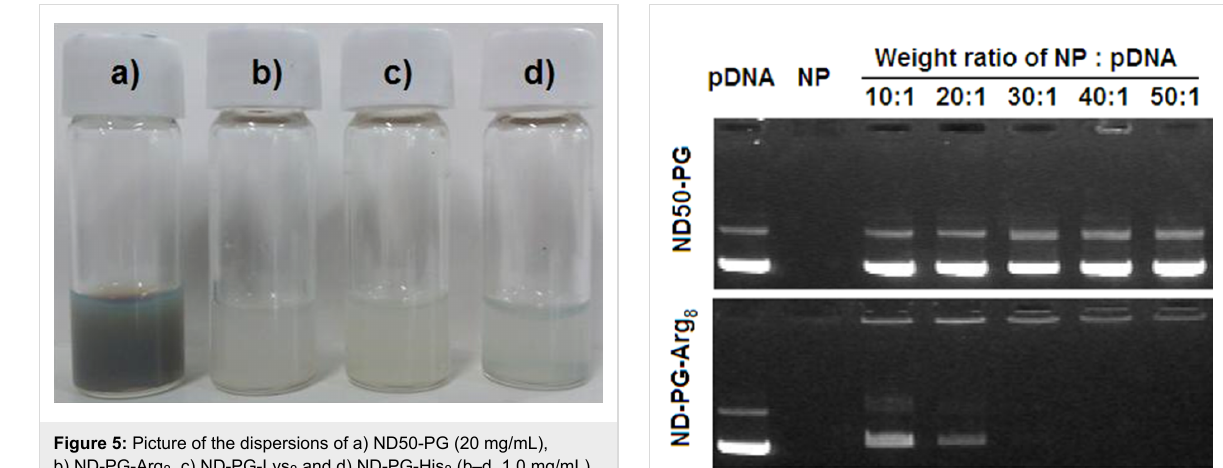
bulk diamond, was kindly provided by Tomei Diamond